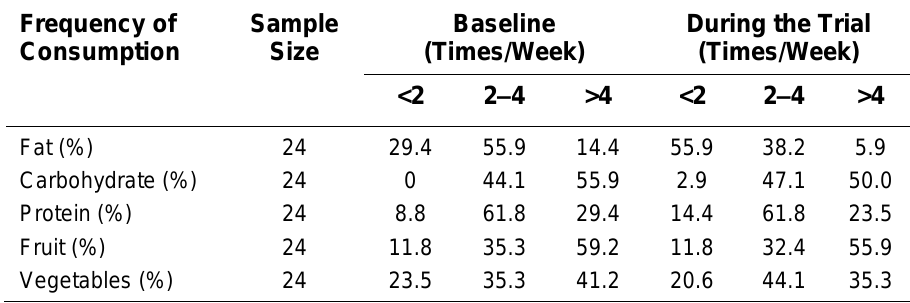
Magnitude of Change in Clinical and Biochemical Parameters of H. persicum and